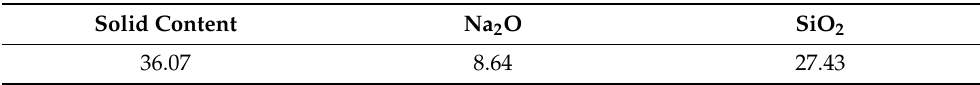
Table 4. Chemical constituents of water glass